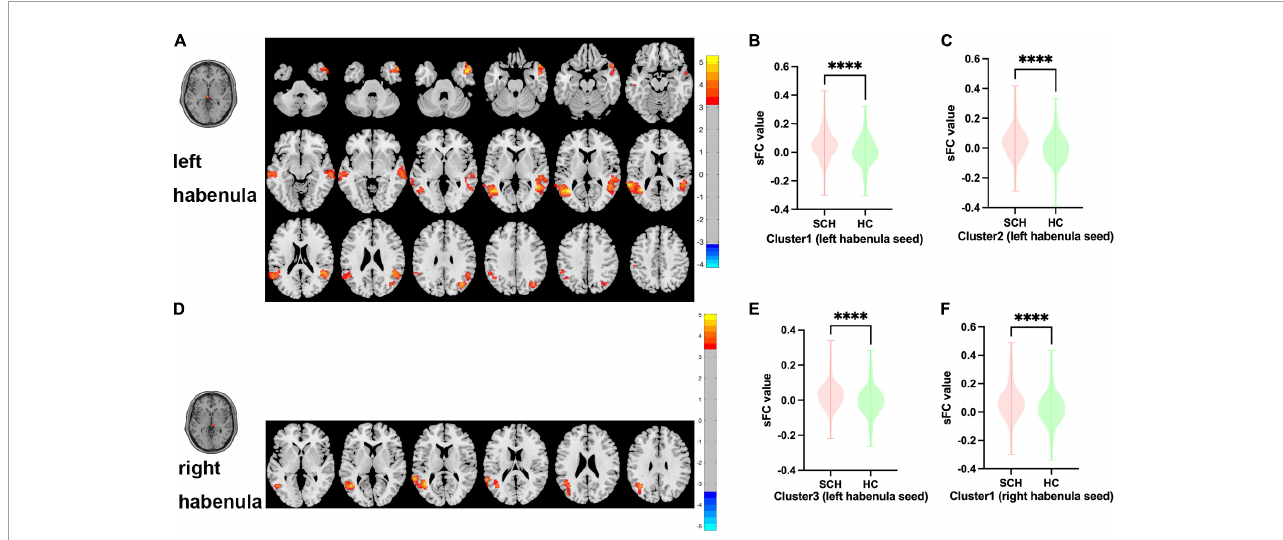
FIGURE1 Brain regions showing abnormal sFC values between SCH and HC groups in MNI space using left and right habenula as seeds. (A) Significant sFC value differences were observed in cluster1 (left middle temporal gyrus, left superior temporal gyrus), cluster2 (right middle temporal gyrus, right superior temporal gyrus) and cluster3(right temporal pole) using left habenula as seed (B,C,E) . Altered sFC values in cluster1, cluster2, and cluster3 between SCH and HC groups using left habenula as seed. (D) Significant sFC value differences were observed in cluster1 (left middle temporal gyrus, left superior temporal gyrus, left angular gyrus) using right habenula as seed. (F) Altered sFC values in cluster1 between SCH and HC groups using right habenula as seed. ∗∗∗∗ Significant at voxel-wise p < 0.005, cluster-wise p < 0.05